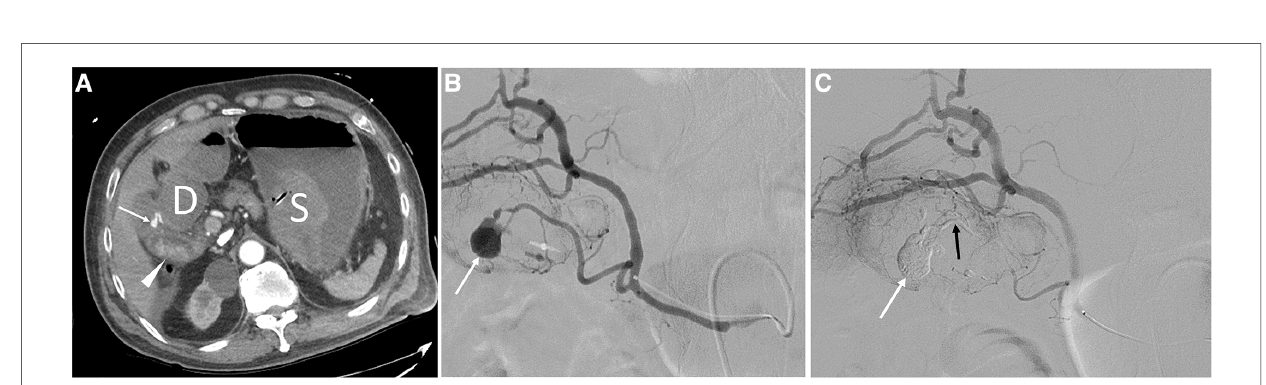
FIGURE 2 2 A 75-year-old male with hematochezia. ( A ) CT scan shows a pseudoaneurysm (arrow) located within the gallbladder. Note the presence of a blood clot with high attenuation in the stomach (S), duodenum ( D ), and gallbladder (arrowhead). ( B ) Right hepatic angiogram shows a pseudoaneurysm (arrow) from the super fi cial cystic artery. A mixture of n-butyl cyanoacrylate and Lipiodol was used for embolization of the bleeding point. ( C ) The fi nal angiogram after embolization of the cystic artery shows a subtraction artifact of the pseudoaneurysm (white arrow) and super fi cial cystic artery (black arrow). Note intact perfusion of the deep cystic artery. The impacted gall stone was thought to induce development of a fi stula between the gallbladder and duodenum, resulting in duodenal ulcer and hematochezia. The patient recovered without development of ischemic cholecystitis and was discharged two weeks after cystic artery